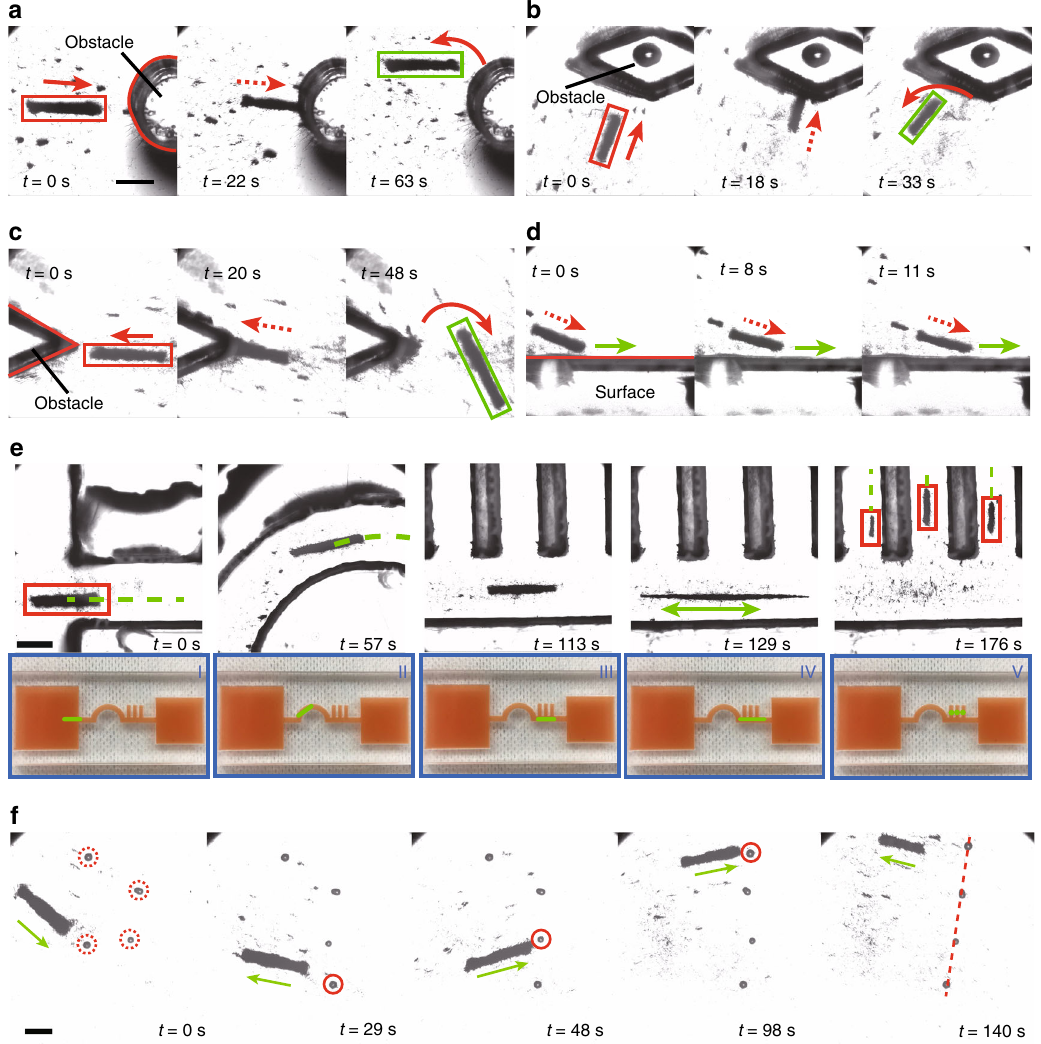
Fig. 4 Stability, controlled locomotion and micromanipulation of the microswarm. a – c Circular and planar surfaces, and a sharp-angled pillar are applied as different boundaries, to investigate the behaviours of the RPNSs. d An RPNS moves along the direction tilted with a planar surface (Supplementary Movie 7). e The demonstration of an RPNS passing through a semi-circular channel, and accessing three targets (Supplementary Movie 8). The RPNS is highlighted by a red rectangle, and the green dotted lines indicate the direction of navigation. Images showing the overall view of the channel network are presented in the blue rectangles below each microscopic image, in which the green ribbons schematically represent the real-time position of the RPNS. f The non-contact manipulation of polystyrene microbeads using an RPNS (Supplementary Movie 9). The red dotted circles indicate the randomly distributed particles, and the green arrows represent the moving direction of the RPNS. The red circles show the particle that is being manipulated. In the demonstrations, the applied amplitude ratio during locomotion is 3.5 and that used for the pattern elongation is 6. The actuating pitch angle is 8°, and the oscillating frequency is 30 Hz. The scale bar is 800 μ